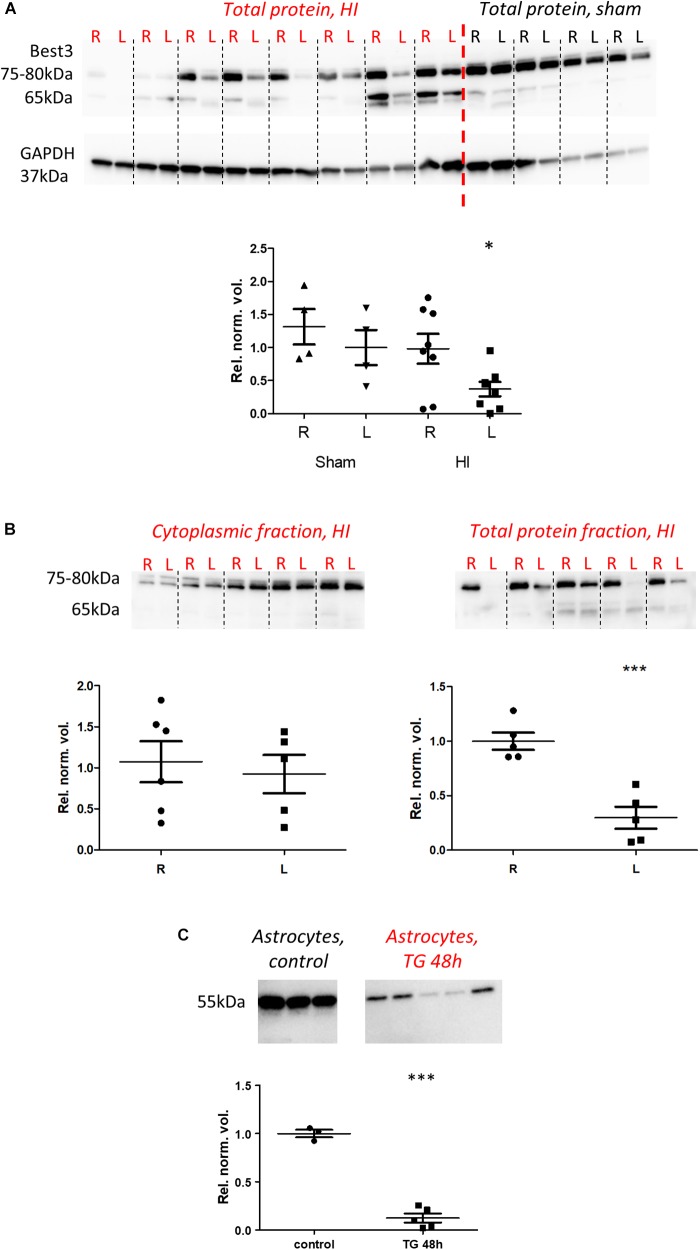
Best3 protein is downregulated in mouse brain tissue and cultured mouse astrocytes after injury. Western blot analysis of brain tissue (A,B) and cultured astrocytes (C). Brain specimens from right uninjured (R) and left injured (L) hemispheres were alternately placed on the gels in (A,B); the same was done for sham-operated animals (A). Two neighboring R and L lanes belong to the same animal. In total protein samples from brain (A) at approximately 75–80 kDa two bands with close molecular weights could be detected; their density was summarized in the analysis. These bands were reduced in injury. Additional lighter pairs of bands could be observed at approximately 65 kDa. The result of subcellular fractionation of brain tissue is shown in (B), where two bands of approximately 75–80 kDa were detected in the cytoplasmic fraction as well as in the total protein fraction. The content of Best3 in the cytoplasm did not change significantly in injury, while Best3 in the total protein fraction was downregulated. In cultured astrocytes (C) treatment with thapsigargin for 48 h (TG 48 h) also caused downregulation of Best3. ∗P < 0.05 by two-way ANOVA and estimated marginal means; ∗∗∗P < 0.001 t-test R vs. L or treated vs. untreated cells. A total of 18 pups (14 HI, 4 sham) were used; for details see section “Materials and Methods.”